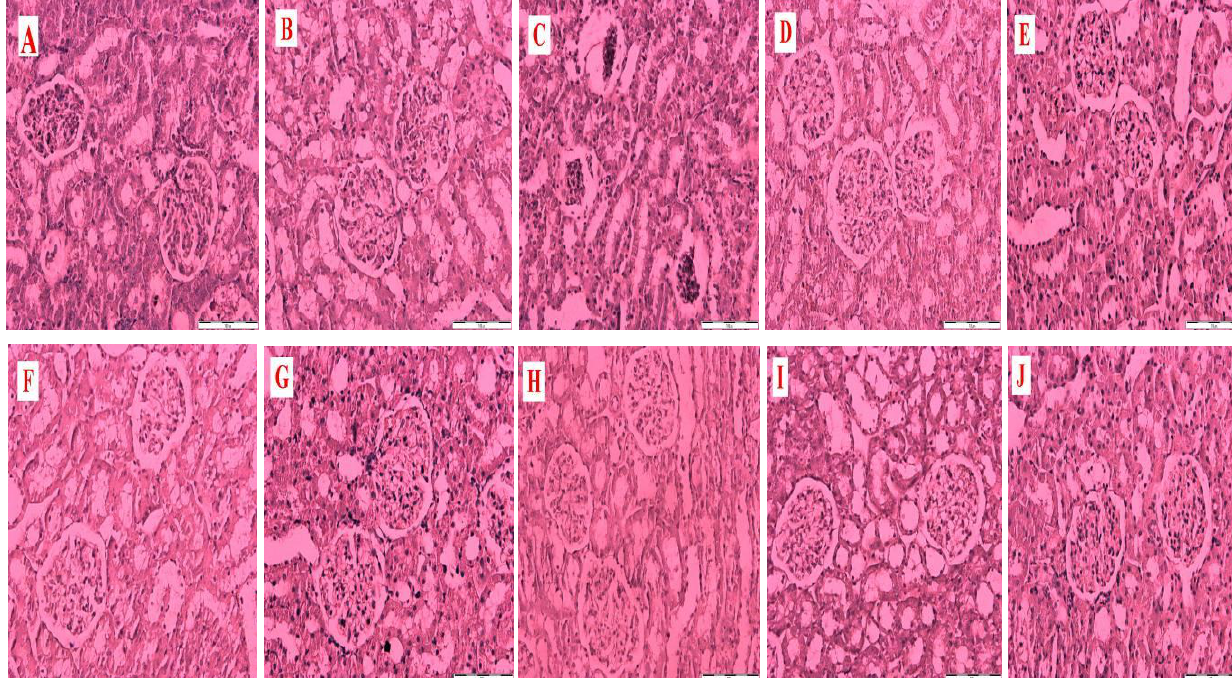
Figure 1. Representative photomicrographs of hematoxylin and eosin staining of the kidney (scale bar: 100 µm) of non-diabetic control rats treated with distilled water ( A ); non-diabetic rats treated with tualang honey ( B ); diabetic control rats treated with distilled water ( C ); diabetic rats treated with tualang honey ( D ); diabetic rats treated with metformin ( E ); diabetic rats treated with metformin and tualang honey ( F ); diabetic rats treated with glibenclamide ( G ); diabetic rats treated with glibenclamide and tualang honey ( H ); diabetic rats treated with metformin and glibenclamide ( I ); diabetic rats treated with metformin, glibenclamide and tualang honey ( J